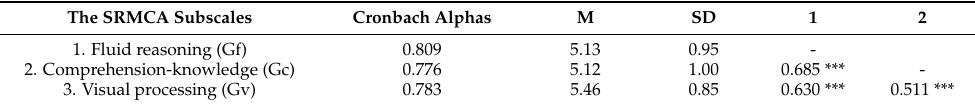
Table 3. The SRMCA: descriptive statistics and correlations between the subscales.